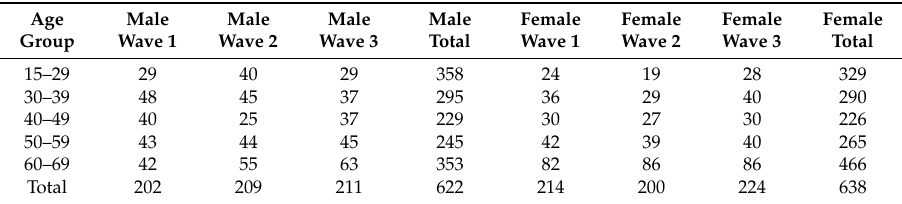
Table 1. The sample